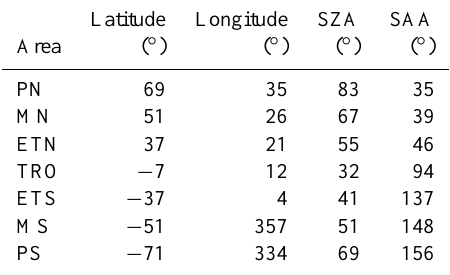
Table 1. Pairs of corresponding latitude, longitude, sun zenith angle (SZA), and relative sun azimuth angle (SAA) of one tangent point in SCIAMACHY limb measurement geometry (PN: polar north, MN: midlatitude north, ETN: extra-tropical north, TRO: tropics, MS: midlatitude south, PS: polar south, ETS: extra-tropical